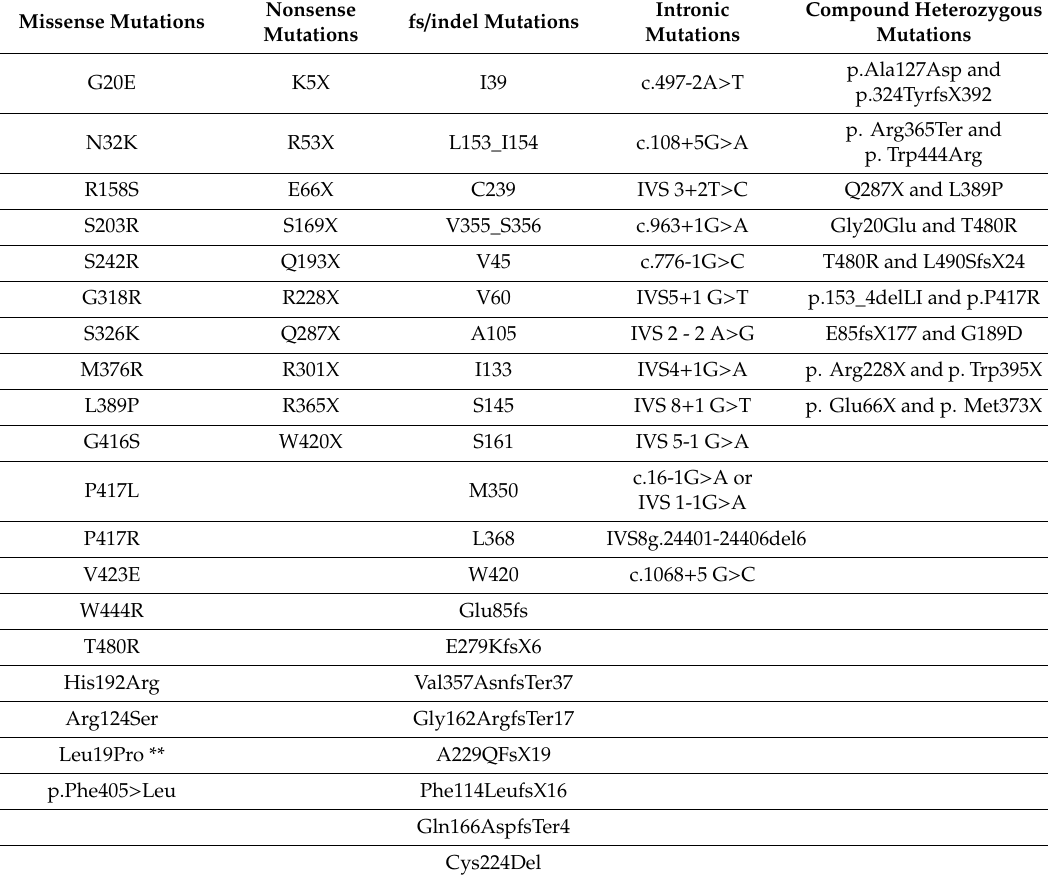
Table 2. Summary of reported seventy di ff erent SLC2A2 mutations (Missense, Nonsense, fs / indel, Intronic, and Compound Heterozygous